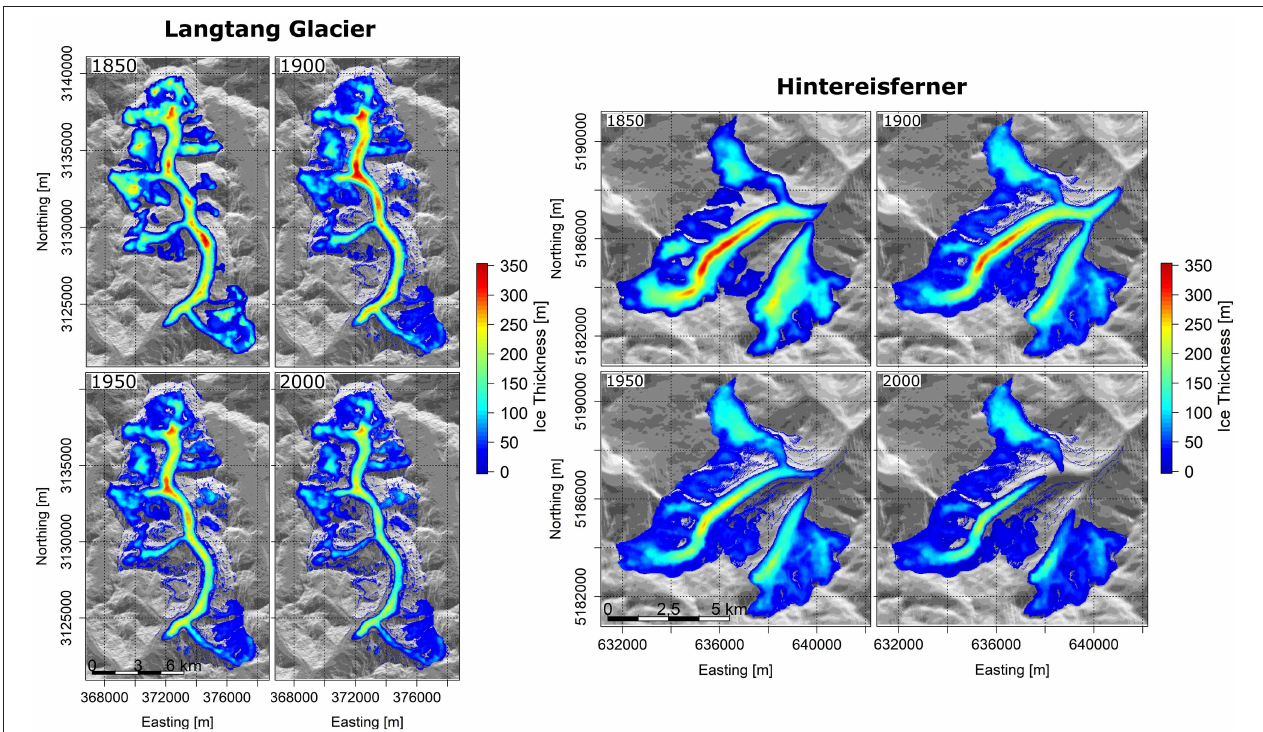
FIGURE 7 | The modeled glacier extents and ice thickness fields of Langtang Glacier (Left) and Hintereisferner (Right) in 1850, 1900, 1950, and 2000 for cold/wet (Langtang Glacier) and cold/dry climate conditions